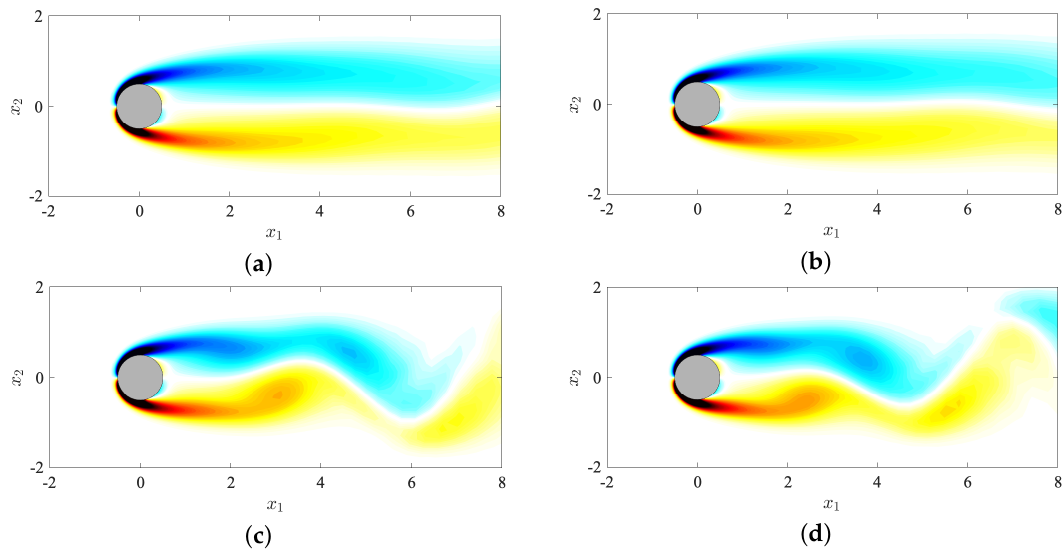
Figure 12. Contours of the vorticity of the flows under ( a ) the control laws (SF-1), ( b ) (SF-2), ( c ) (OF-1), and ( d )